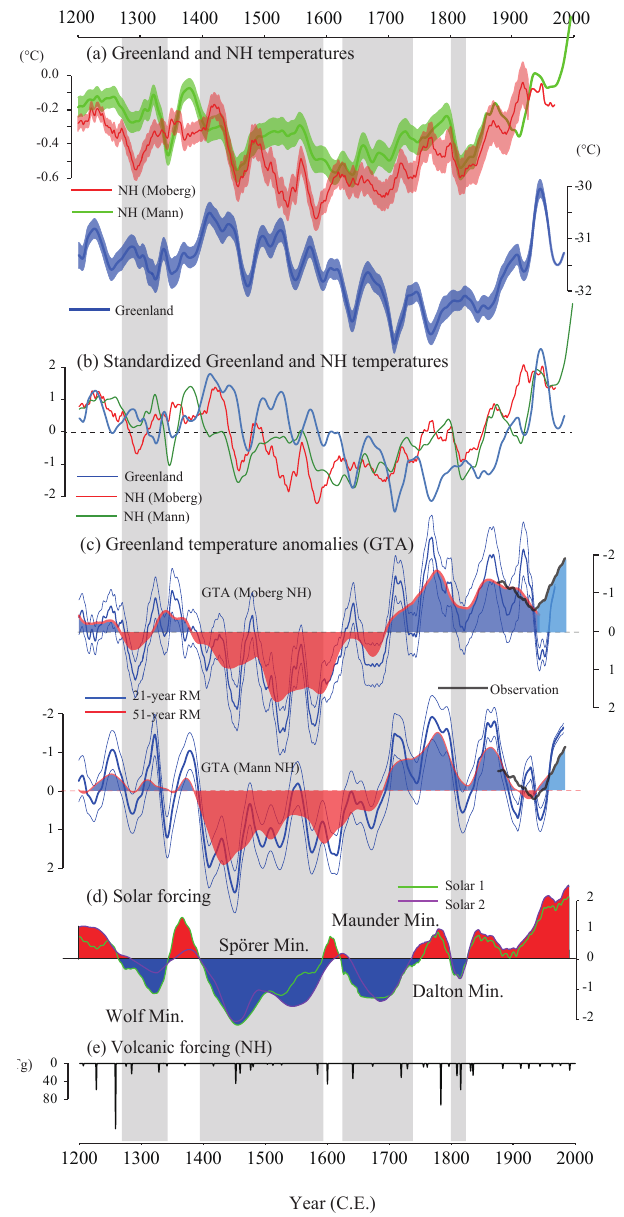
Fig. 3. Climate records for the 1200–2010 period. (a) Greenland temperature (blue) (Kobashi et al., 2010) and the NH temperature from Moberg et al. (2005) (red) and Mann et al. (2009) (green) in 21 RMs with 95% confidence intervals (2 σ ). (b) The blue line is the standardized Greenland temperature (Kobashi et al., 2010). The red and green lines are the standardized NH temperatures (Moberg et al., 2005; Mann et al., 2009). (c) Greenland temperature anomalies (GTA [ G-NH ] ) calculated from Greenland temperature and the NH temperature, as shown in panel (b) . The blue and red lines are smoothed by 21 RMs with 95% confidence intervals (2 σ ) and by 51 RMs, respectively. The area between the red line and zero is colored blue for the region above zero and red for the region below zero. The black line is the GTA [ G − NH ] calculated from the observed temperatures (51 RMs) in Fig. 1. Transparent light blue shading indicates areas below the observed GTA [ G − NH ] (black line) and above zero. Values of − 1.27 and − 0.49 are added to the observed GTAs [ G-NH ] with the NHs by Moberg et al. and Mann et al., respectively, to account for the differences in the average GTAs [ G-NH ] between the proxy and the observations for the overlapping period. Note that the y-axis of the GTA [ G − NH ] is reversed to allow for comparison with the solar variability. (d) The purple line represents the solar forcing from Bard et al. (2000) and Crowley (2000) spliced into that from Lean et al. (1995), and the green line is from Delaygue and Bard (2009) spliced into that from Wang et al. (2005) The areas are colored red when the values are above zero (stronger sun) and blue when the values are below zero (weaker sun). The standardized time series of the solar forcings is shown. The grey areas are the periods of weaker suns used for the statistical tests. (e) The volcanic forcing for the NH from Gao et al. (2008) is plotted as a